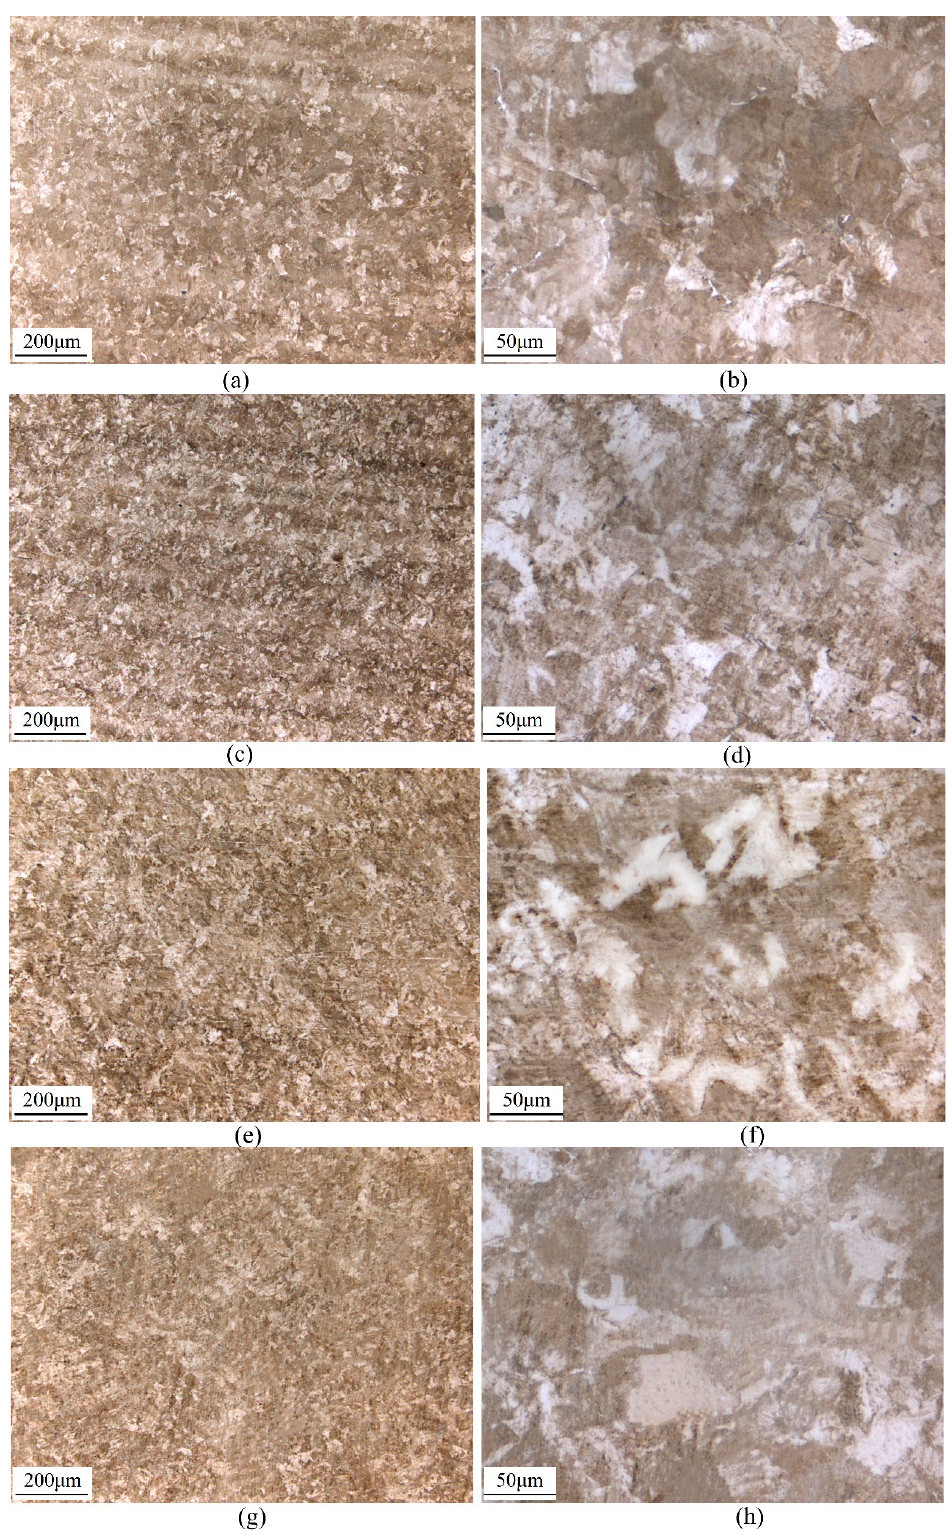
Figure 7. The metallographic structure of U71MnG: ( a , b ) in the L–T direction of rail head (CSP), ( c , d ) in the L–T direction of rail head (CRP), ( e , f ) in the L–S direction of rail head (CSP), ( g , h ) in the L–S direction of rail waist (CRP).